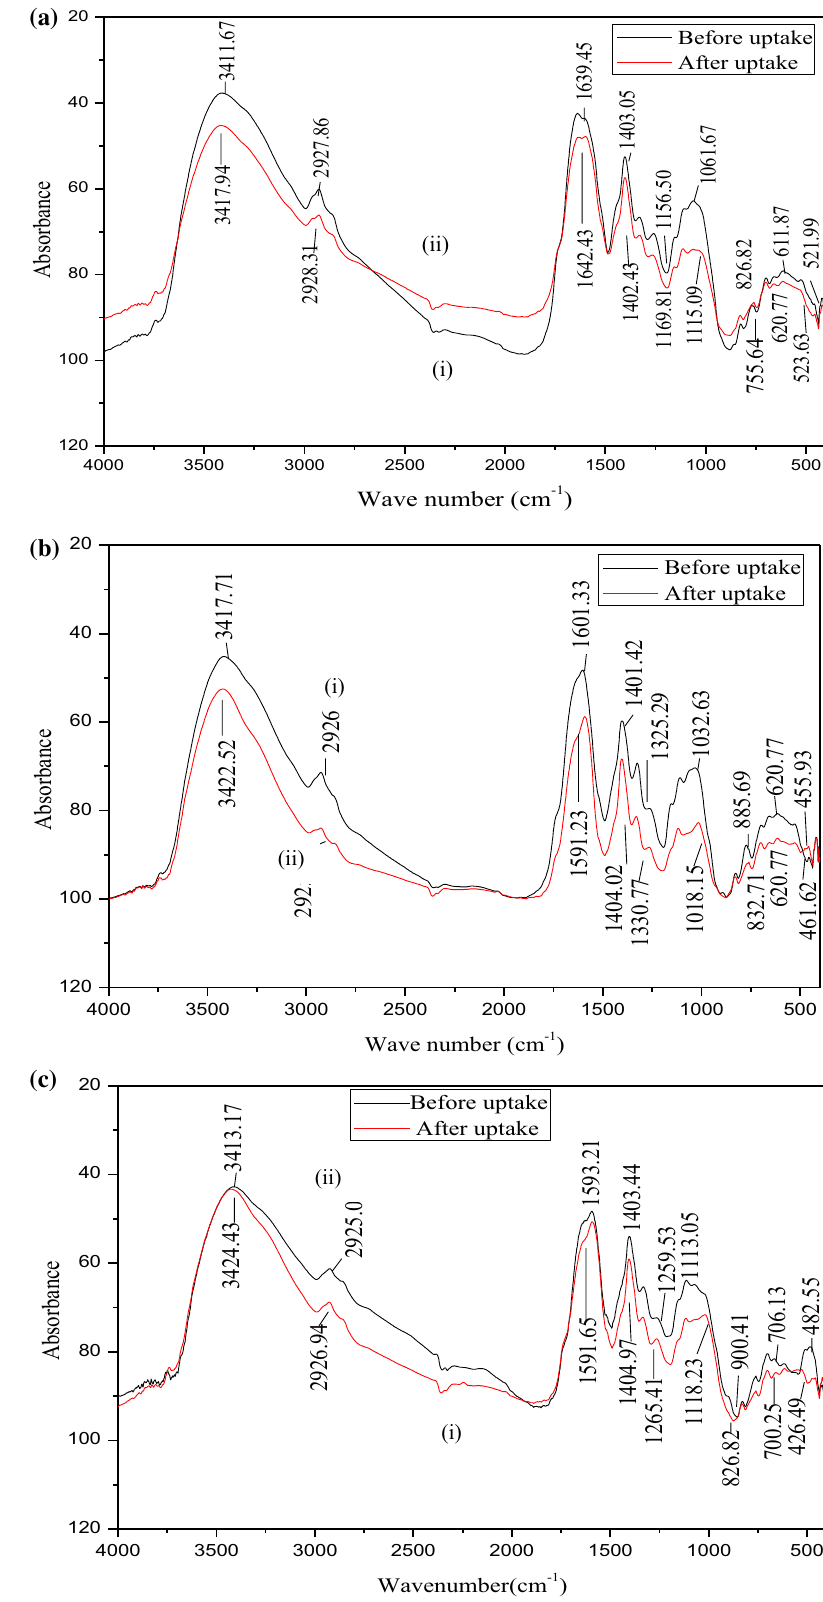
Fig. 1 a FTIR analysis of plant leaves: (i) Unloaded with phe- nol and cyanide and (ii) loaded with phenol and cyanide. b FTIR analysis of plant stem: (i) Unloaded with phenol and cya- nide and (ii) loaded with phenol and cyanide. c FTIR analysis of plant root: (i) Unloaded with phenol and cyanide and (ii) loaded with phenol and cyanide